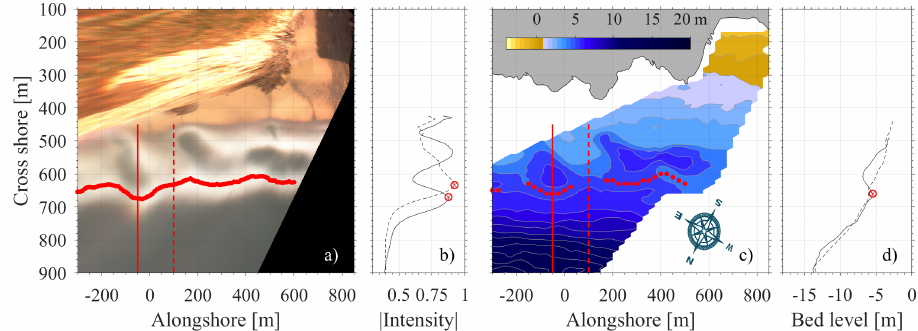
Figure 11. Sub-tidal bar detection using horizontally projected pixel intensities in ( a , b ) and bar detection using a video-derived bathymetry ( c , d ). Both applications are executed on data from the same day and same hour but with typically 20 min delay between the Timex and bathymetry (due to the collection set up). The vertical solid and dashed lines in ( a , c ) correspond to taken cross-sections as presented in respectively ( b , d